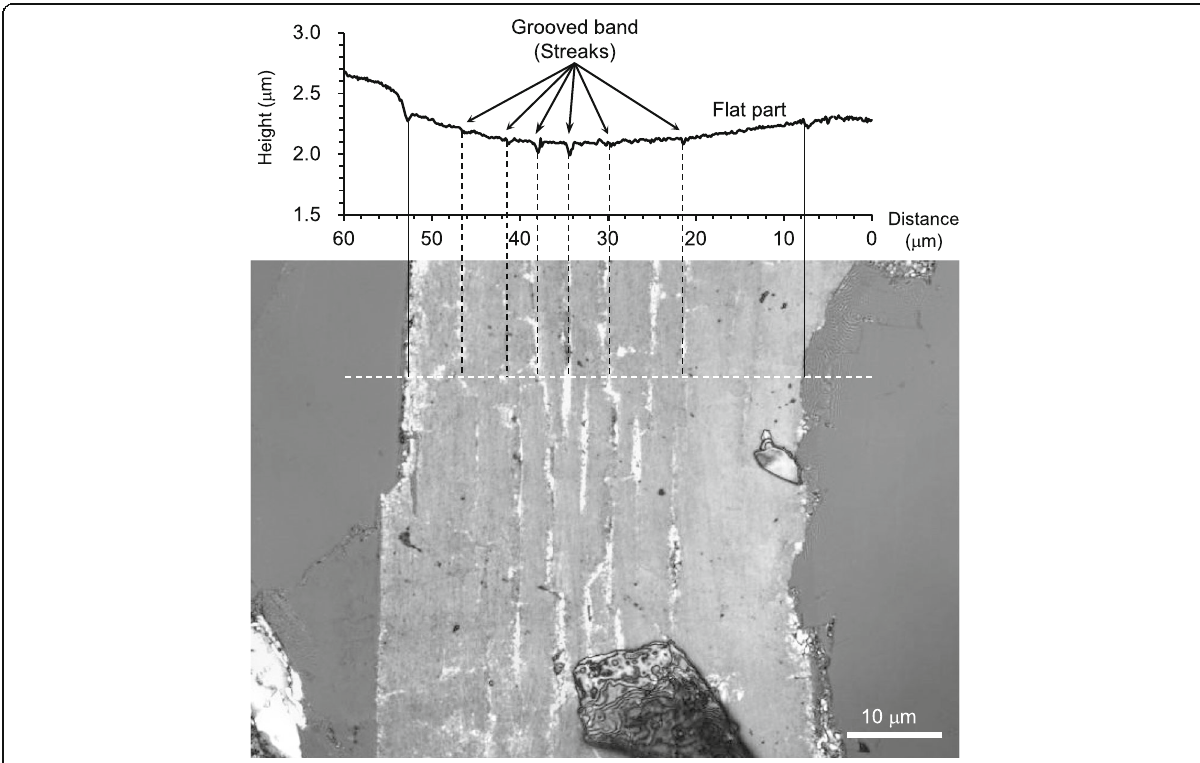
Fig. 2 Depth profile through the polished graphite with the CLSM image focused at a certain depth. The confirmed locations of grooves are indicated by thick dotted lines. The edges of graphite are indicated by solid